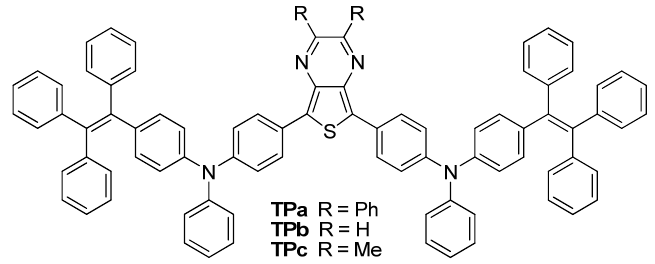
Figure 2. Structure of thienopyrazine-based AIE dyes.